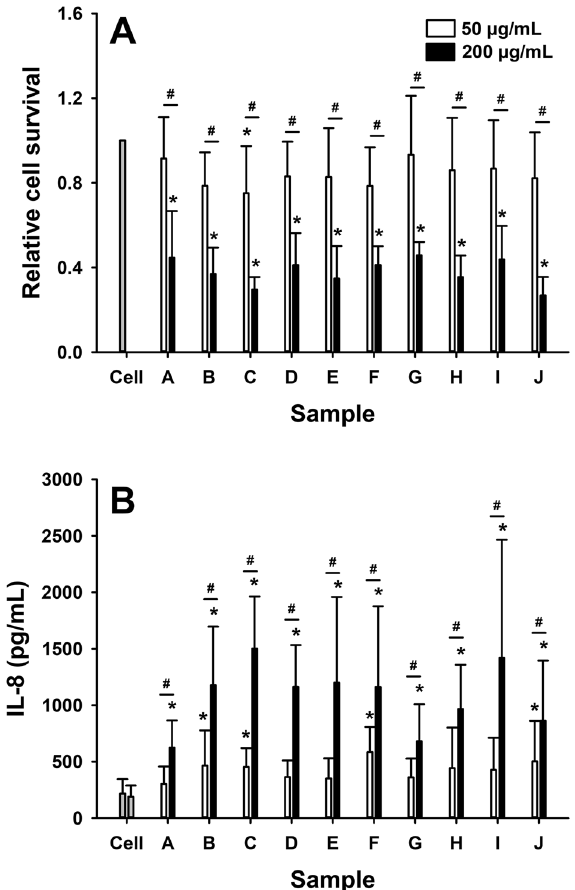
Figure 3. Relative cytotoxicity ( A ), measured by Trypan blue exclusion relative to control (cell only), and IL-8 production, measured in the cell supernatant by ELISA, in macrophages (THP-1 derived) in response to 24 h exposure to 50 µg/mL (white bars) or 200 µg/mL (black bars) of coal particles (samples A–J). Data are presented as mean (SD). *p < 0.05, versus cell only; # p < 0.05, 200 µg/mL vs 50